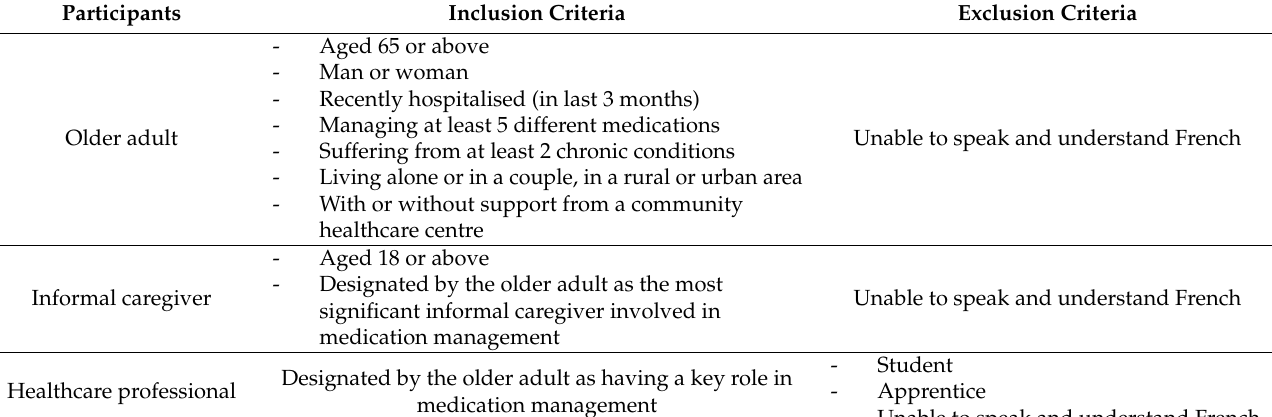
Table 1. Participant inclusion and exclusion